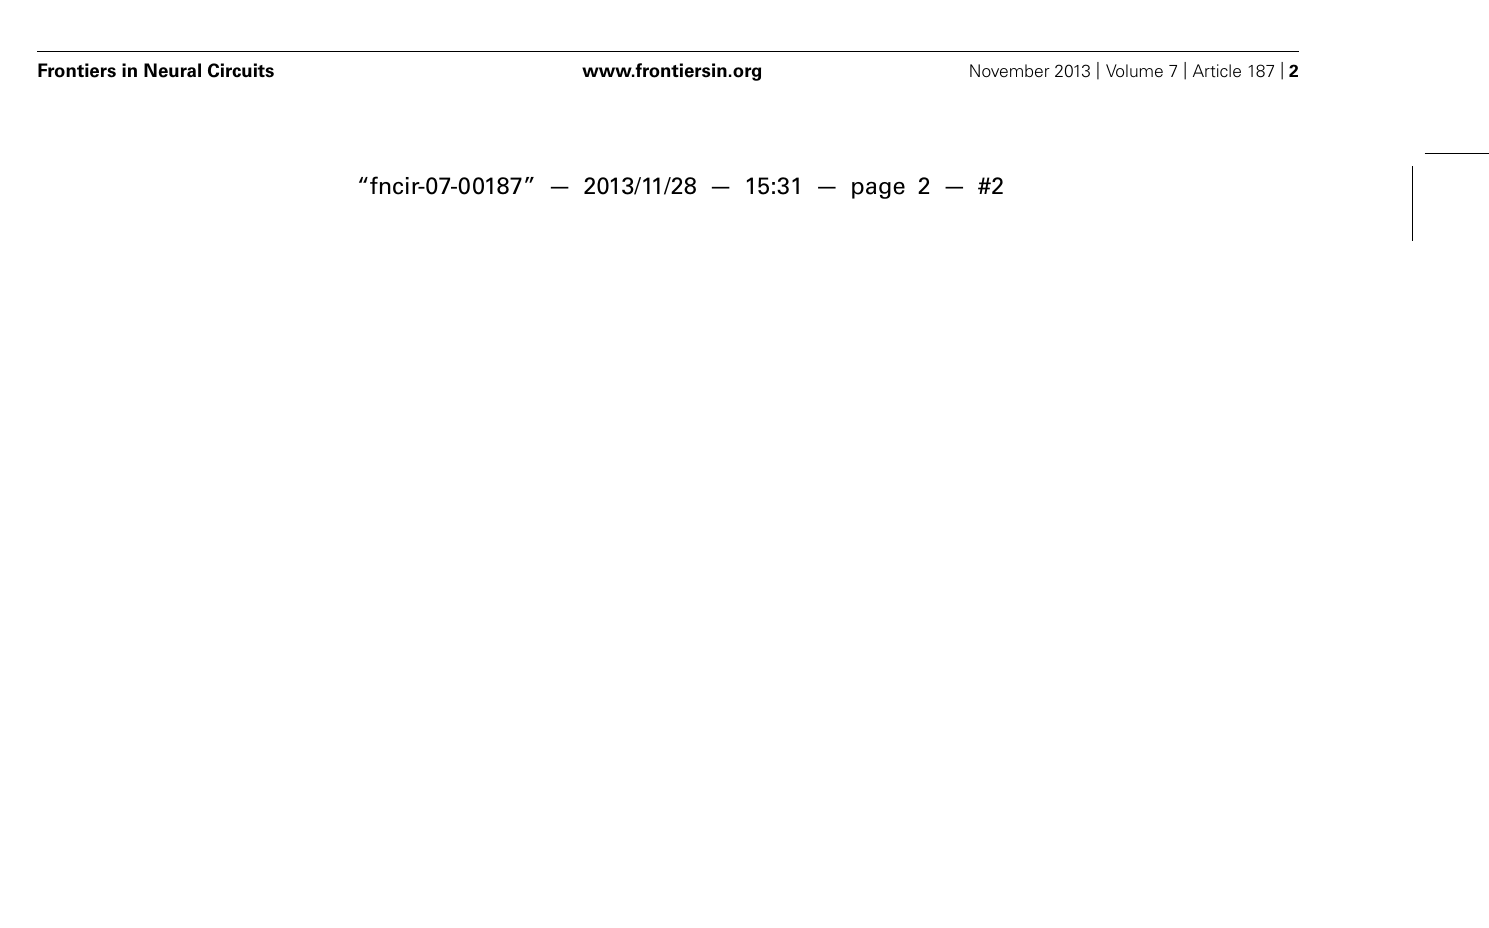
FIGURE 2 |The association of butanone and food to enhance chemotaxis to butanone (Torayama etal., 2007). (A) Scheme for experiments. (B) Chemotaxis index of olrn-1 and olrn-2 mutants after butanone is associated with or without food.